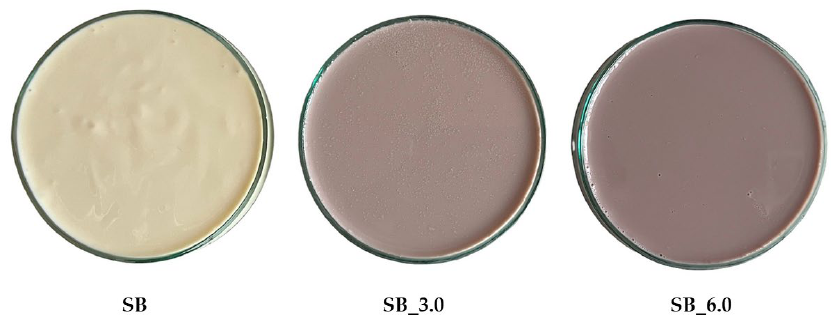
Figure 2. Fermented soy beverages with acai powder. SB: fermented soy beverage; SB_3.0: fer- mented soy beverage with 3.0% additive acai powder; SB_6.0: fermented soy beverage with 6% acai powder. Table 5. Color and gloss of fermented soy beverage with acai